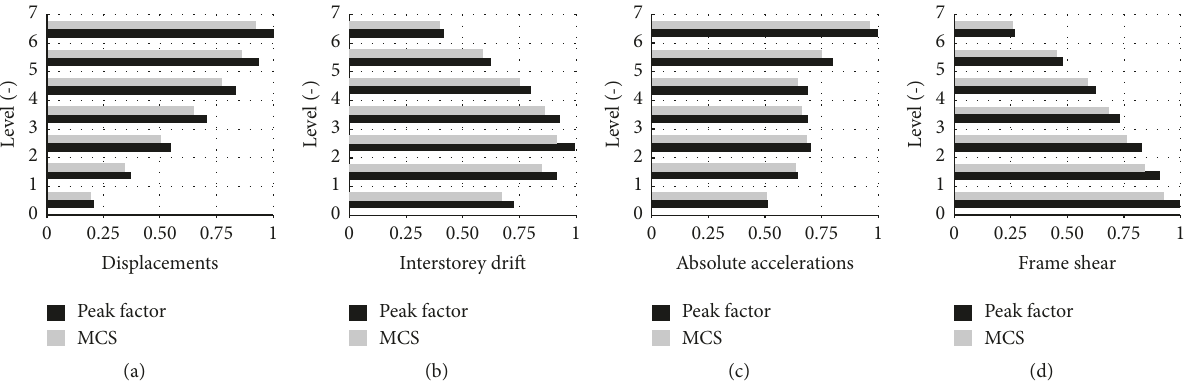
Figure 9: Comparison of the response parameters of interest for the NR configuration obtained through the peak factor estimation and through MCS